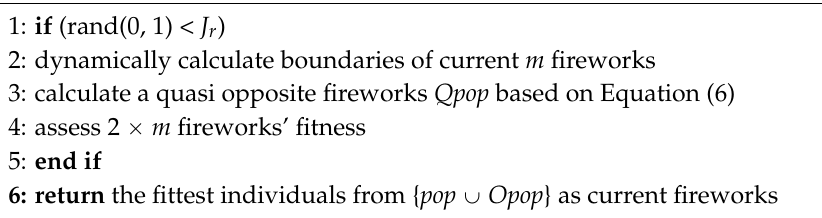
Algorithm 5 Opposition-Based Generation Jumping